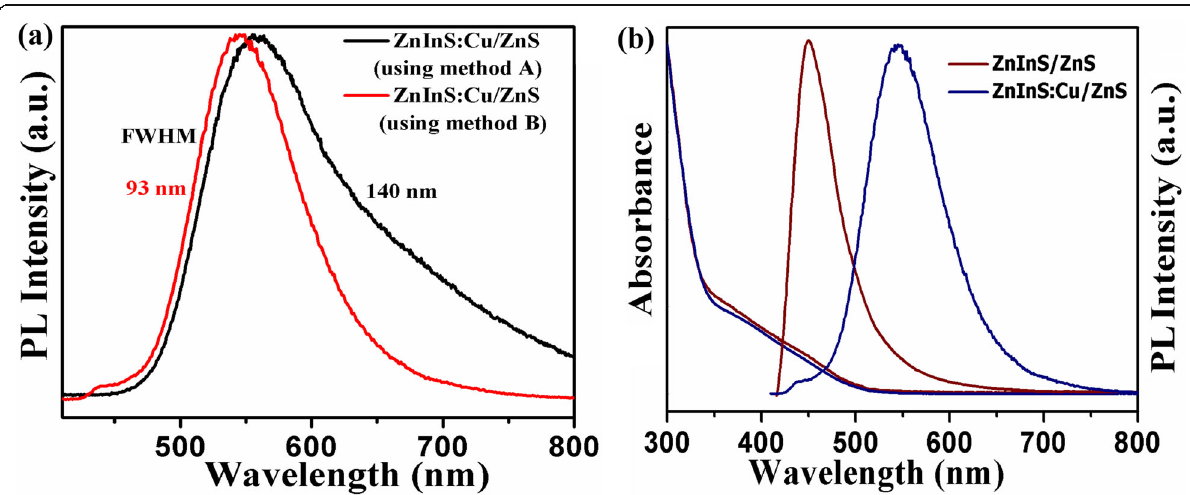
Fig. 3 a PL emission spectra of ZnInS:Cu/ZnS CNCs synthesized with method A (using powdered indium precursor as previously reported in literature) and method B (using modified method, which used indium oleate as a precursor in this work). b PL emission spectra of ZnInS/ZnS (undoped) and ZnInS:Cu/ZnS (doped)